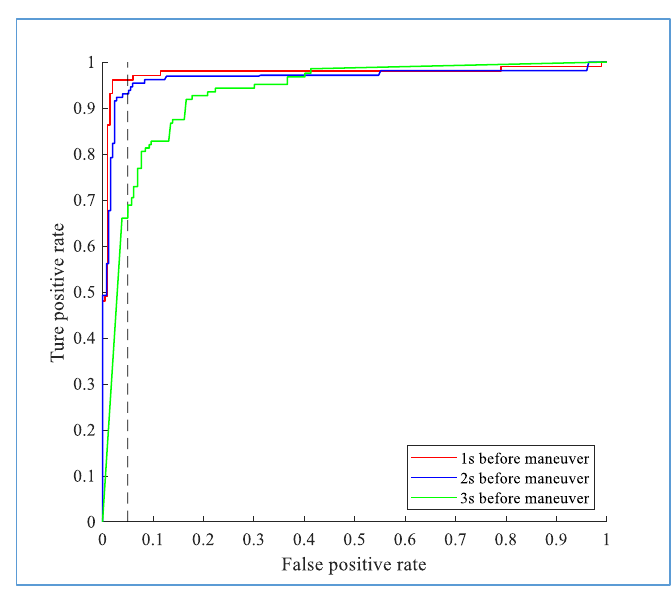
Figure 17. Performance of the proposed method at different times before the actual maneuver for the TR.